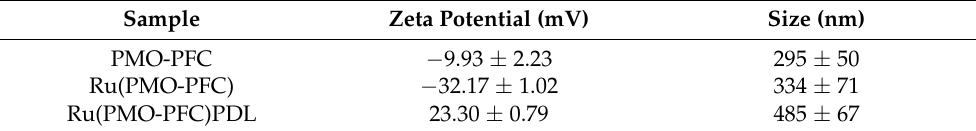
Table 1. Zeta potential and size measurement (mean value ± standard deviation) of particles.